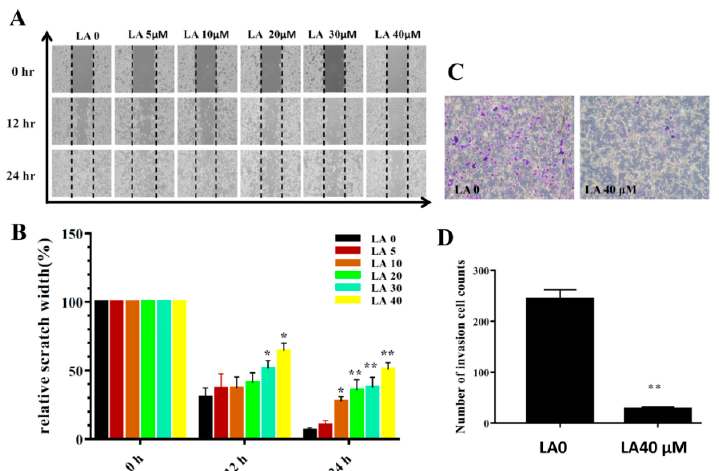
Figure 4. Licochalcone A (LA) treatment inhibited migration and invasion in wound healing assay ( A , B ) and transwell invasion assay ( C , D ). ( A ) Cell migration with and without LA treatment at different time points. ( B ) Measured width of the cell-free gap. A greater width indicates reduced cell migration. ( C ) Crystal violent-stained invasive cells, indicating that LA inhibited invasion. ( D ) Invasive cell numbers in the transwell assay. The data are presented as mean ± SD of three independent experiments (n = 6). * p < 0.05, ** p < 0.01 compared to untreated cells (0 μ M LA).